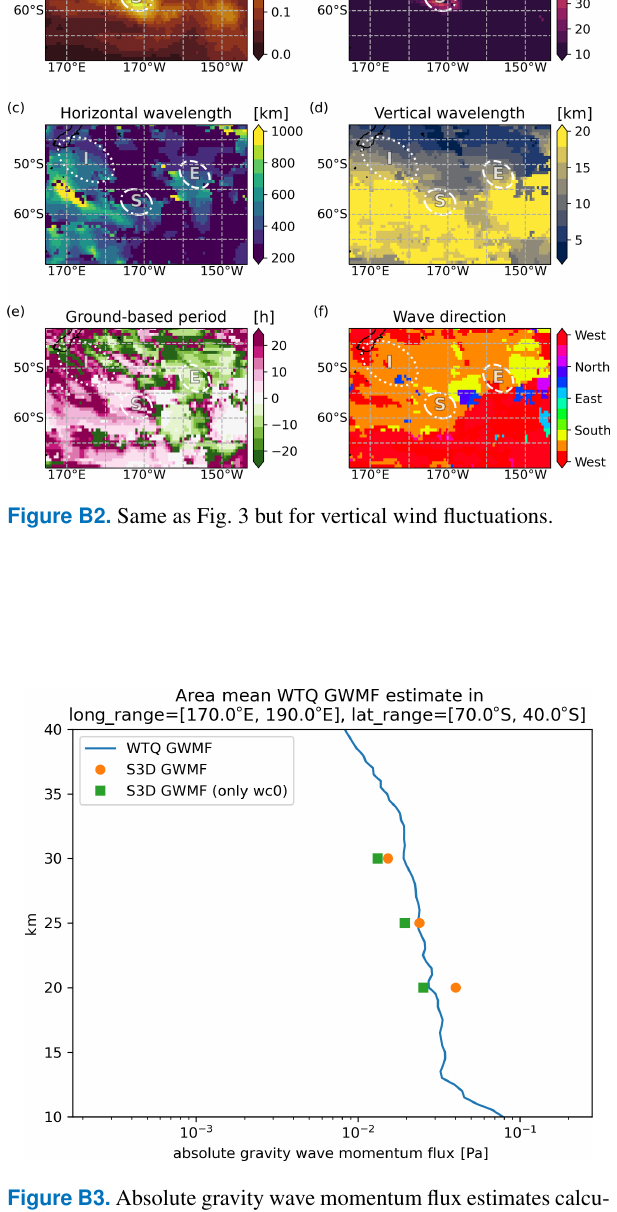
Figure B3. Absolute gravity wave momentum flux estimates calcu- lated with two different methods, where the blue line shows GWMF from the wind and temperature quadratics (WTQ) approximation used before by Geller et al. (2013) and Stephan et al. (2019a), and the orange circles and green squares show GWMF calculated us- ing Eq. (7) from Ern et al. (2004). The green squares only consider one fitted wave component for the calculation, whereas the orange circles show the GWMF for two wave components.